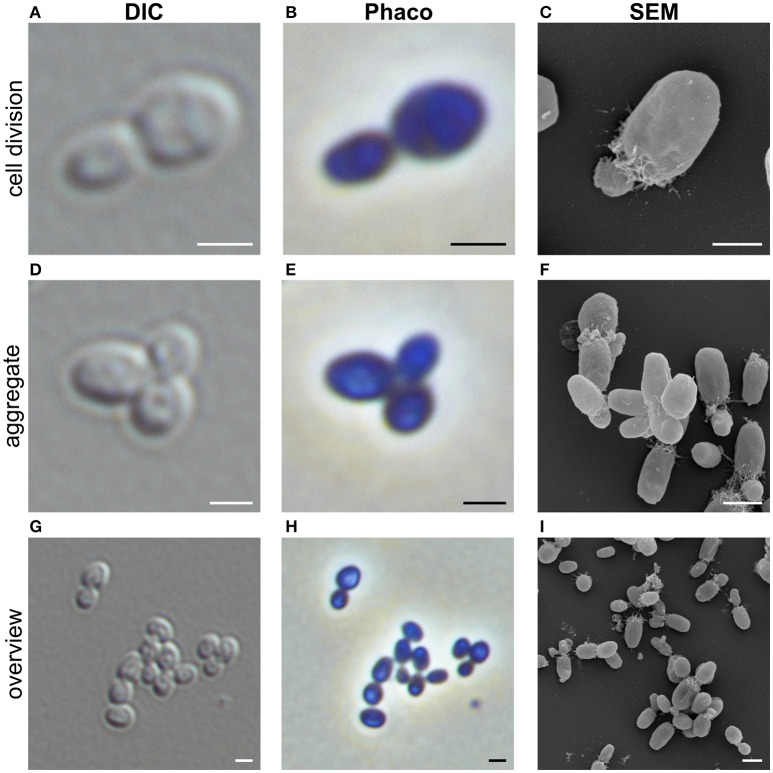
Morphology of strain NH11T. Representative differential interference contrast (DIC), Phase-contrast (Phaco) and scanning electron microscopic (SEM) micrographs of strain NH1. Shown are individual representative cells during division through polar budding (A–C) and -aggregate formation (D–F). In addition, an overview of multiple cells from a representative liquid culture is provided (G–I). Bar, 1 μm.